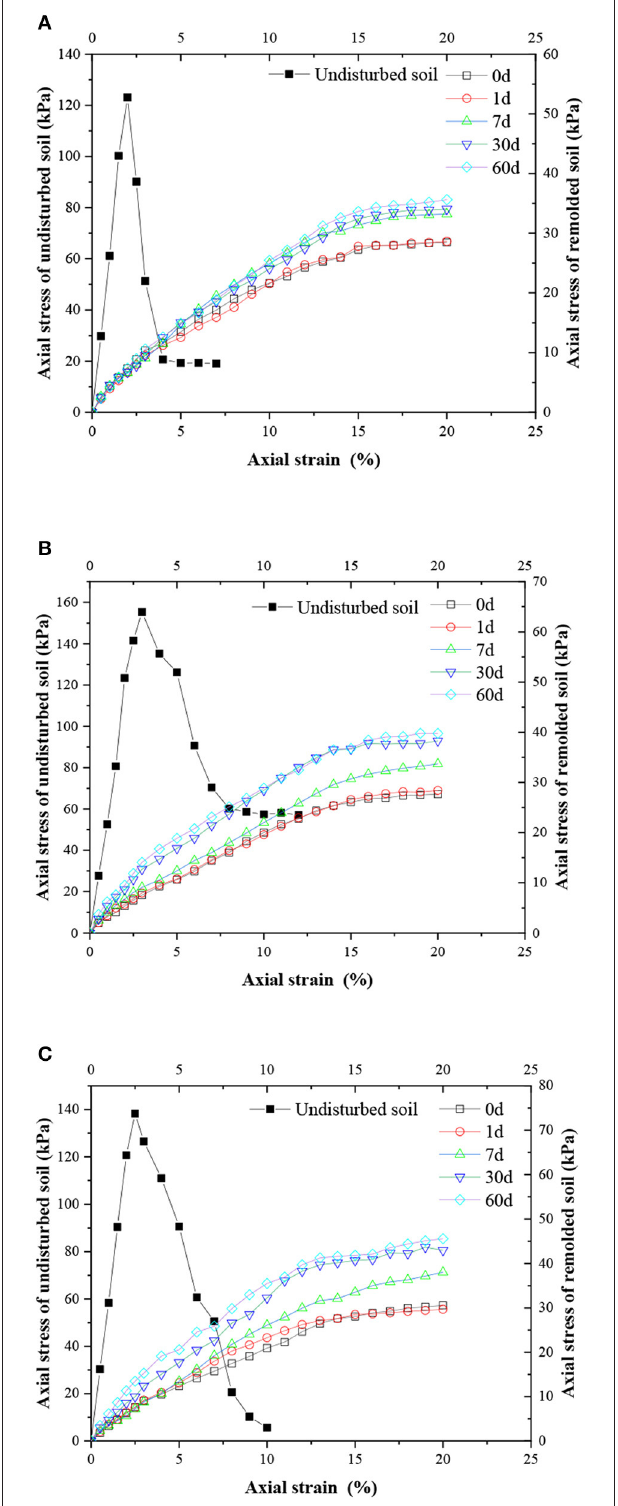
FIGURE 1 | The curve of relationship between axial strain and axial stress of the samples. (A) Curve of relationship between axial strain and axial stress of soil sample 1. (B) Curve of relationship between axial strain and axial stress of soil sample 2. (C) Curve of relationship between axial strain and axial stress of soil sample